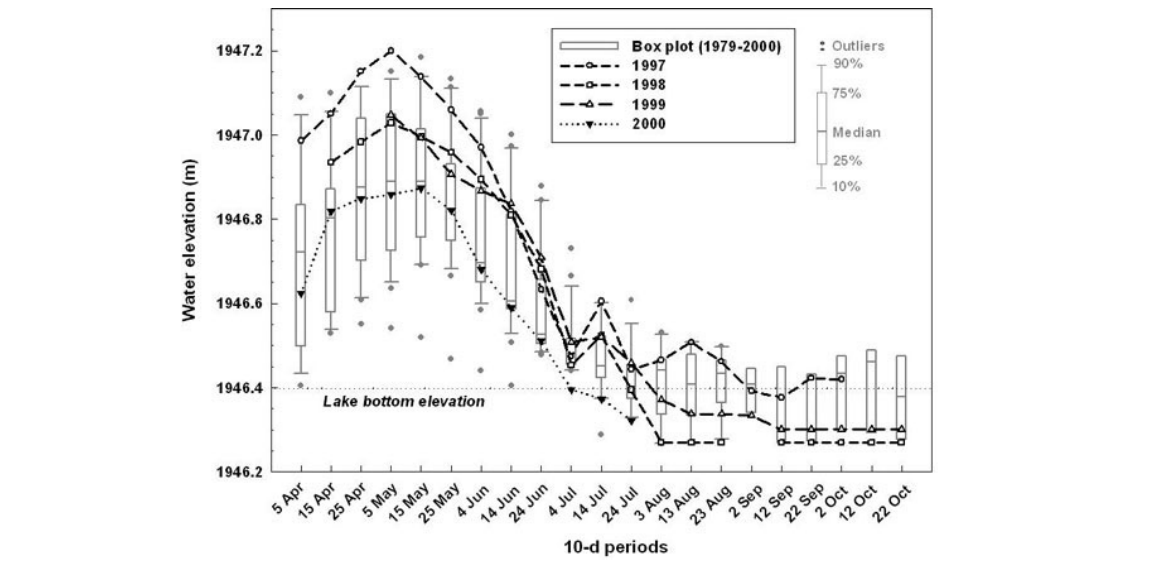
Fig. 1. Seasonal changes in water levels recorded at Beavertail Point, Grays Lake, Idaho, for